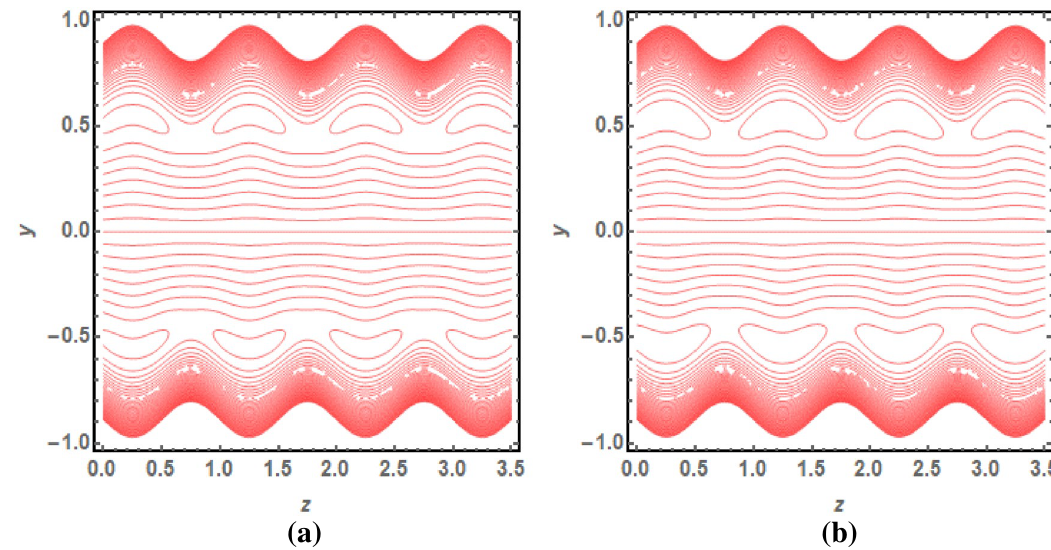
Figure 7. ( a ) Streamline for Q = 1.4 and σ < 0 . ( b ) Streamline for Q = 1.6 and σ < 0